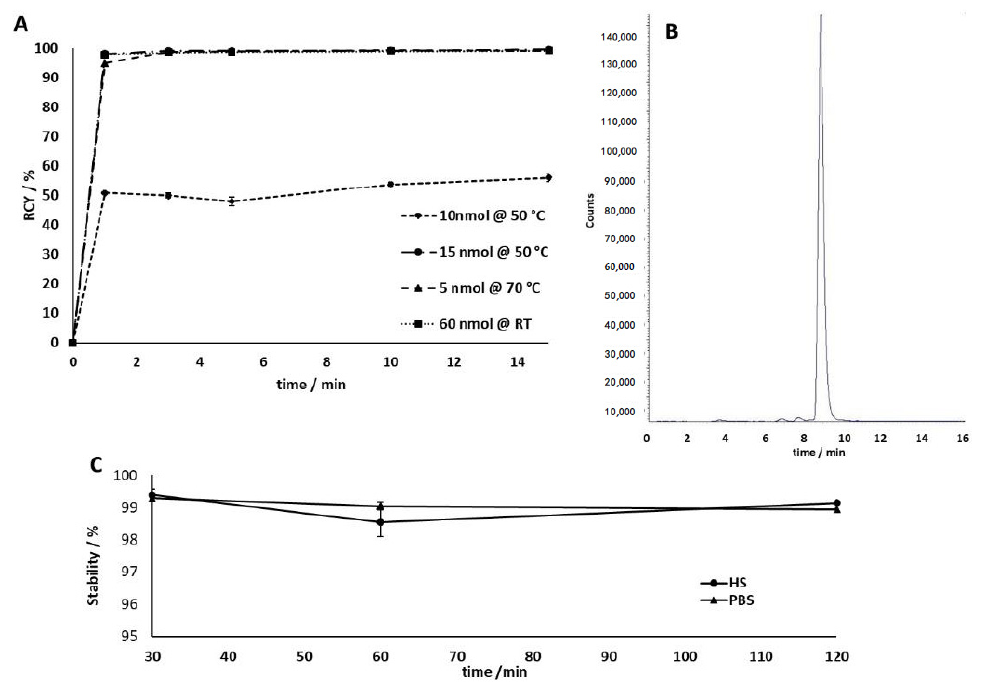
Figure 6. ( A ) Kinetic studies of 68 Ga-radiolabeling of DATA 5m .SA.KuE for various amounts of precursor and different temperatures. Labeling of 15 nmol at 50 ◦ C, 5 nmol at 70 ◦ C and 60 nmol at RT resulting in quantitative RCYs after one minute. Radiolabeling of 10 nmol at 50 ◦ C results in a RCY of 56% after 15 minutes. ( B) Radio-HPLC of [ 68 Ga]Ga-DATA 5m .SA.KuE. t R (free gallium-68) = 2.0 min; t R ([ 68 Ga]Ga-DATA 5m .SA.KuE) = 8.8 min. Radio-HPLC confirmed purity and high RCY of [ 68 Ga]Ga-DATA 5m .SA.KuE. ( C ) Stability studies for [ 68 Ga] Ga-DATA 5m .SA.KuE complex in human serum (HS) and phosphate buffered saline (PBS) of intact conjugate at different time points.